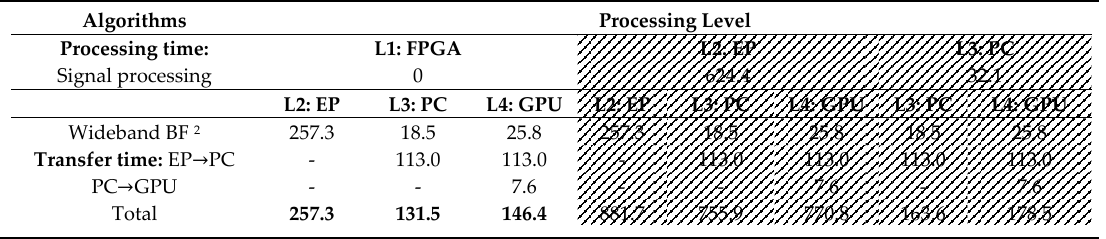
Table 5. Processing and transfer times 1 for acoustic imaging algorithms.